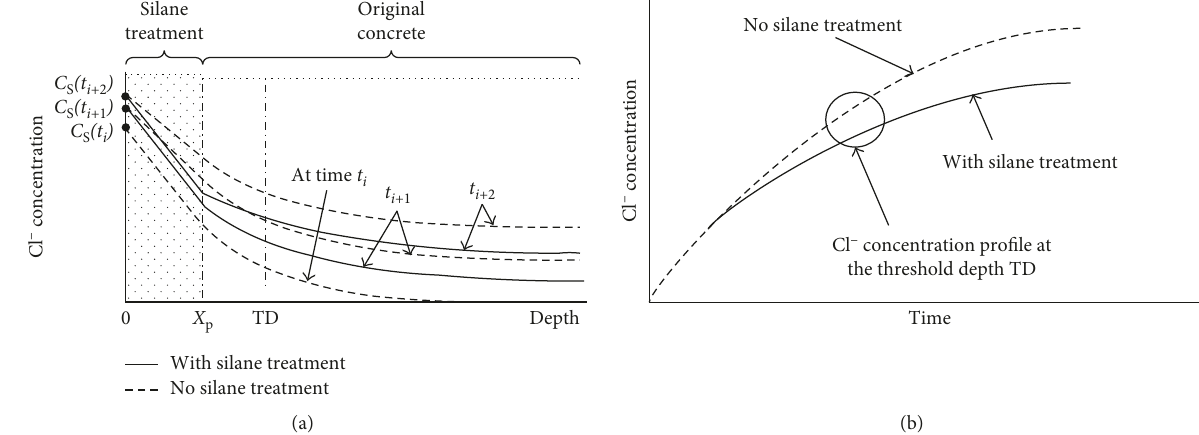
Figure 1: Chloride profile: with and without silane treatment. (a) Chloride-depth profile. (b) Chloride-time